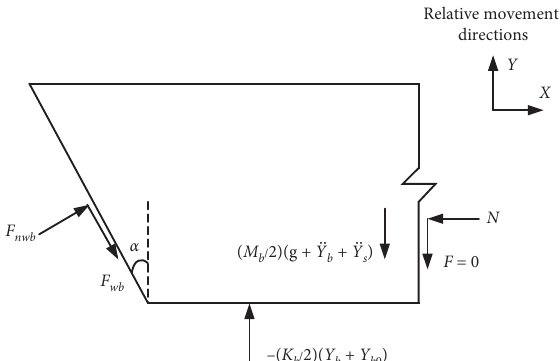
Figure 6: Mechanical model of the